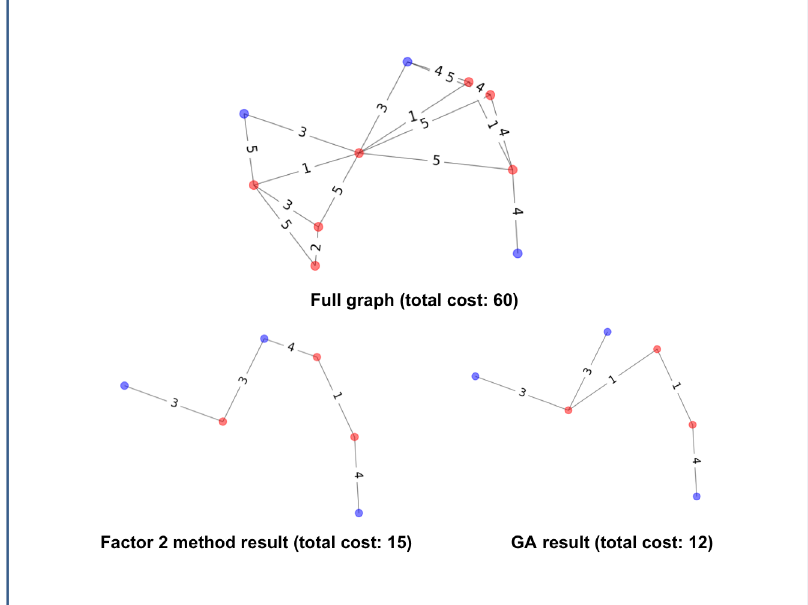
Figure 15. Two methods comparison example. The full red–blue visibility graph ( top ) has a total cost of 60. The resulting graphs of the 2-factor ( bottom left ) method and the GA method ( bottom right ) have total costs of 15 and 12,